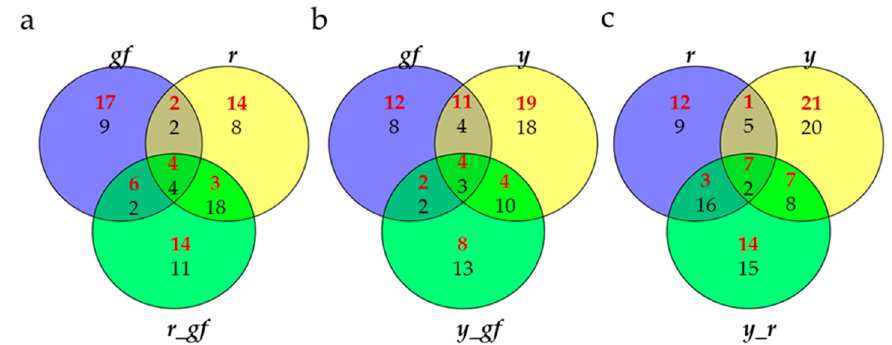
Figure 7. Venn diagrams for ( a ) gf , r and r_gf ; ( b ) gf , y and y_gf ; ( c ) r , y and y_r . Red and black numbers correspond to up- and down-regulated metabolites, respectively .